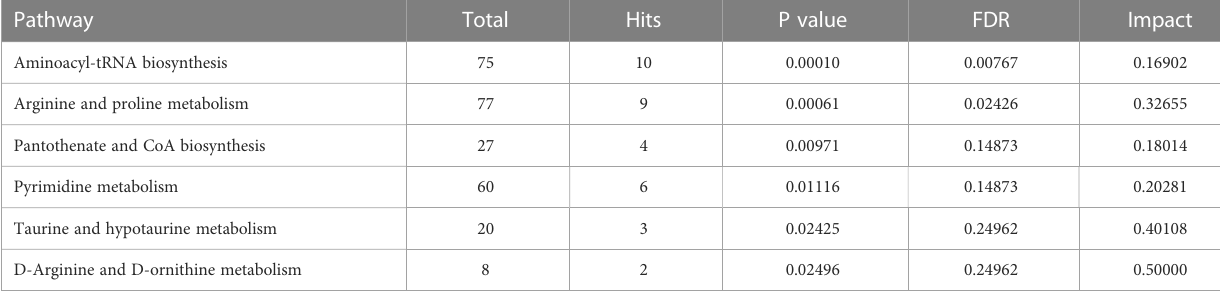
TABLE 2 Signi fi cant pathways in negative-ion model. Pathway